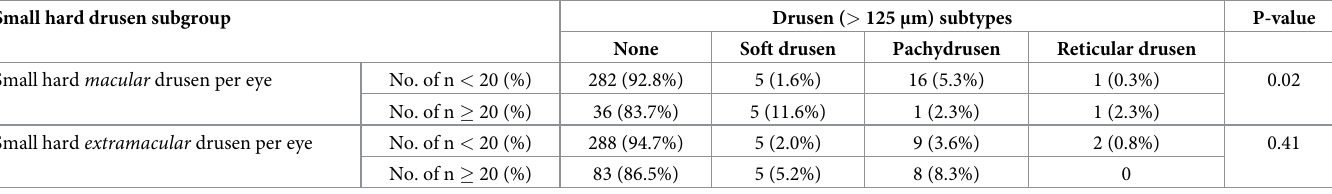
Table 5. Distribution of large drusen ( > 125 μ m) subtypes among participants with � 20 or < 20 small hard drusen. Small hard drusen